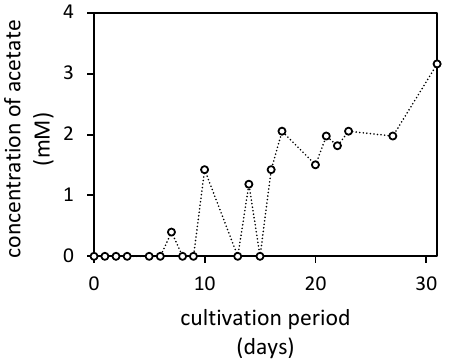
Figure 6. Changes in acetate concentration in culture medium supplemented with Mn(IV)-oxide (MnO 2 ) incubated in the presence of Aspergillus niger for 31 days. The concentration of acetate in other treatments was below the detection limit (0.004 mM) of applied analytical procedure.